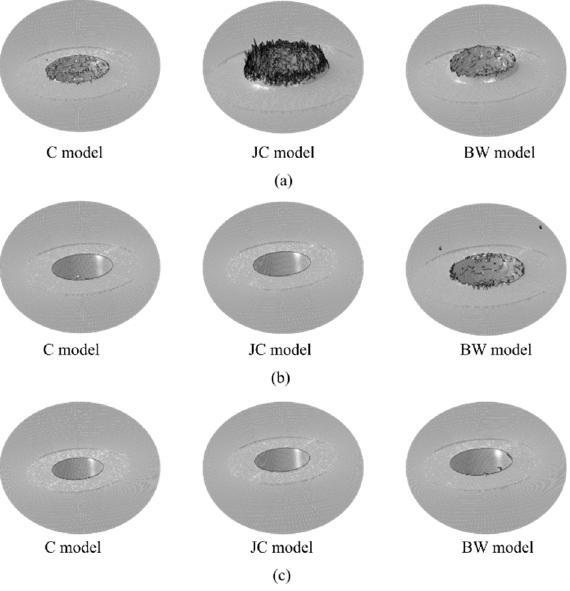
Figure 18. Details of the failure mode of targets impacted by blunt projectiles: ( a ) AA 5754 ‐ H111; ( b ) AA 6082 ‐ T6; and ( c ) AA 2024 ‐ T351.